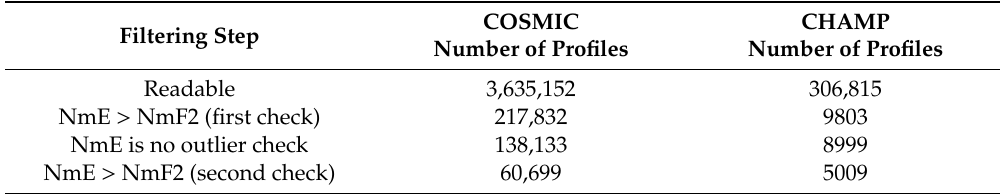
CHAMP datasets. Table 1. Numbers of profiles remaining for individual filtering steps for the COSMIC and